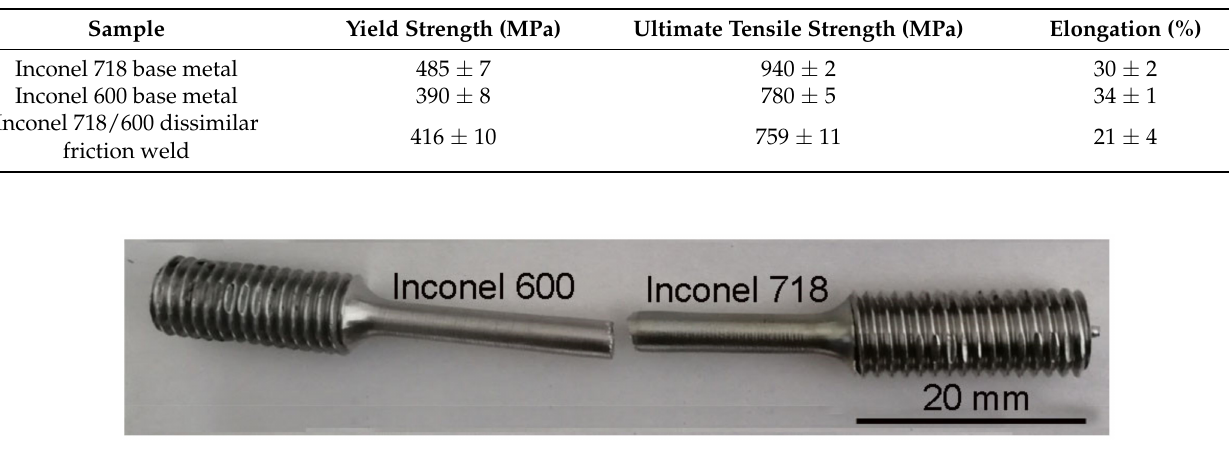
Figure 6. Failure location of the transverse tensile specimen corresponding to the dissimilar Inconel 600/Inconel 718 friction welded